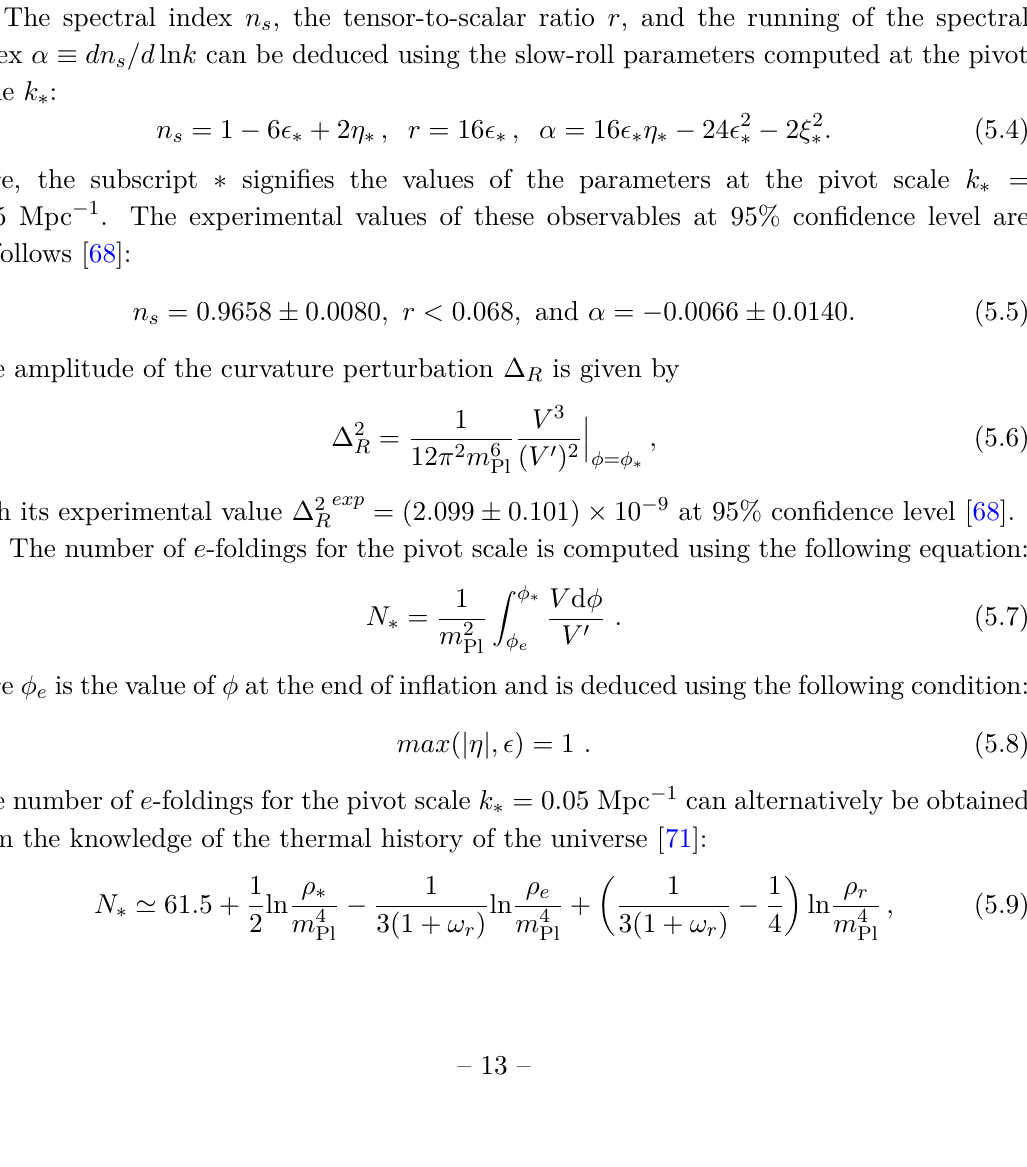
. (b) Contour plot of τ X 2 L 2 R 3 C 1 B − L → G 2 L 1 Y 3 C